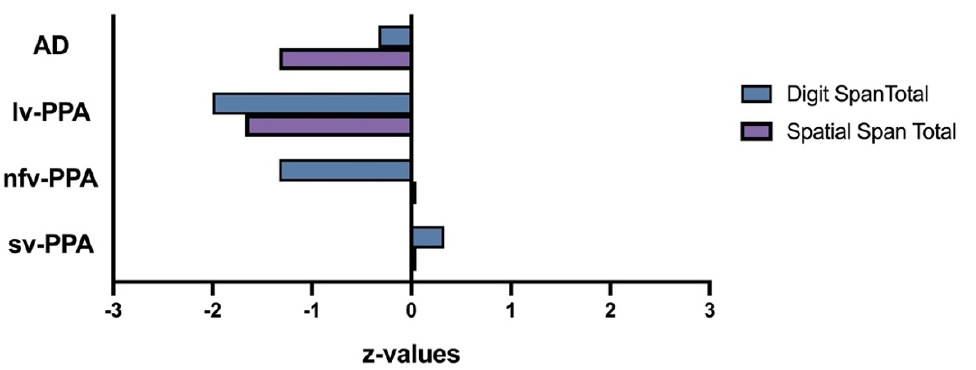
Figure 3. Digit and Spatial Span total raw scores graphically represented as age-adjusted z-values. Overall performance on Digit Span was very impaired for the lv-PPA patient, borderline-impaired for the nfv-PPA patient, and average for the sv-PPA and AD patients. Overall performance on Spatial Span was borderline-impaired for the lv-PPA and AD patients, and average for the nfv-PPA and sv-PPA patients. Overall Digit Span was significantly (0.05) worse than Spatial Span for the nfv-PPA patient; with the reverse pattern (i.e., Spatial < Digits) found for the AD patient. There was no statistical difference between test modality for lv-PPA and sv-PPA patients (statistical thresholds were taken from Table F4 [Appendix F] of the WMS III Scoring Manual).